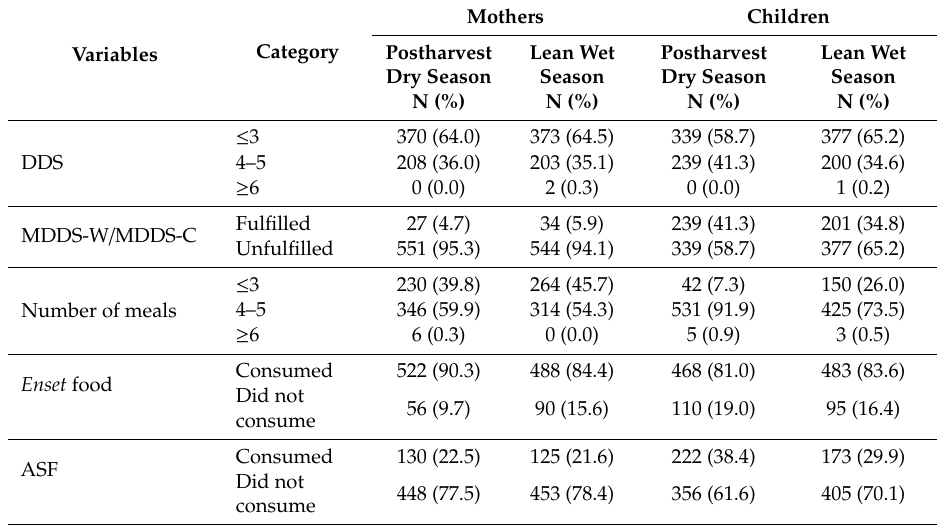
Table 3. Descriptive statics of dietary diversity of MCP in postharvest dry and lean wet seasons (N = 578), January–June